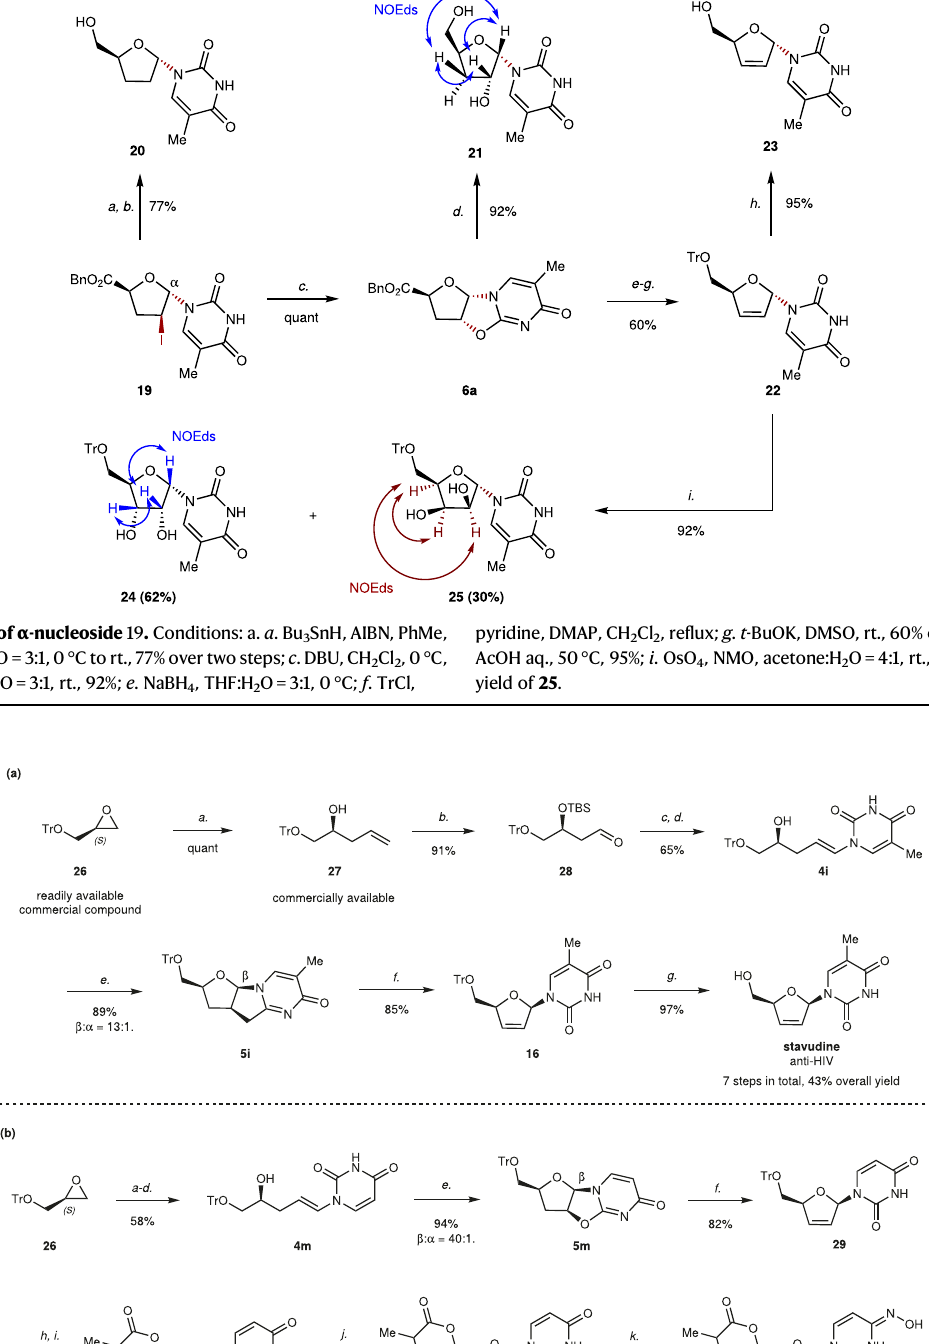
Fig. 7 | Synthesis of two FDA-approved agents stavudine and molnupiravir. a Synthesisofstavudine; b Synthesisofmolnupiravir.Conditions: a .vinylmagnesium bromide(1MinTHF),CuI,THF, – 78°C,1h,quant; b .TBSCl,imidazole,CH 2 Cl 2 ,0°C tort.,thenO 3 ,Et 3 N, – 78°Ctort.,91%; c .CrCl 2 ,CHI 3 ,THF,0°C,82%; d .nucleobases (thymine for 4i , uracil for 4m ), CuTc, K 3 PO 4 , DMEDA, DMF, 75°C, then TBAF, 79%